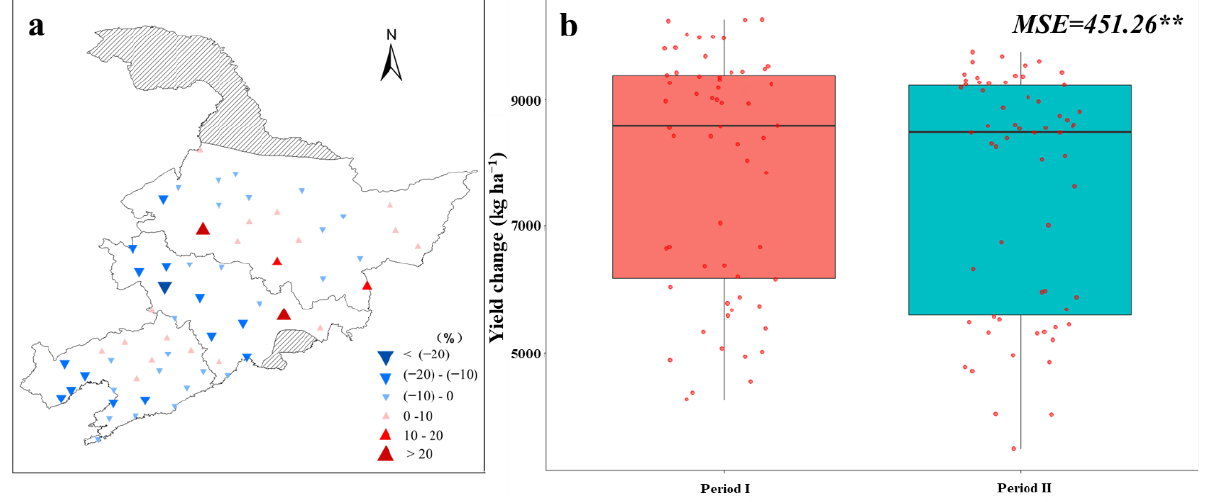
Figure 6. The temporal and spatial distribution characteristics of yield changes under a normal climate. (( a ) Spatial distribution of yield changes at 62 stations; ( b ) Comparison of the yield change in the two time periods (each box represents the yield of normal climate during the period). The red dots indicate the yield change of the stations under normal conditions. ** Significant at p ≤ 0.01.